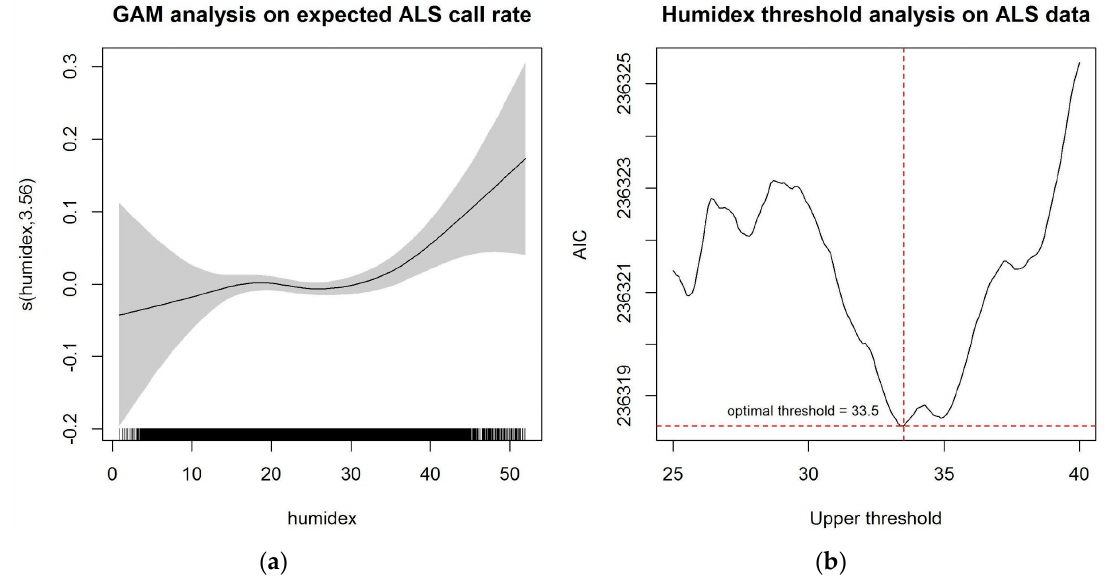
Figure 2. Temporal analysis on extreme heat threshold for ALS data: ( a ) Generalized additive model with penalized regression spline of log expected daily ALS call rate and humidex; ( b ) Plot of AIC for the likelihood model when choosing optimal threshold between 25 °C and 40 °C.